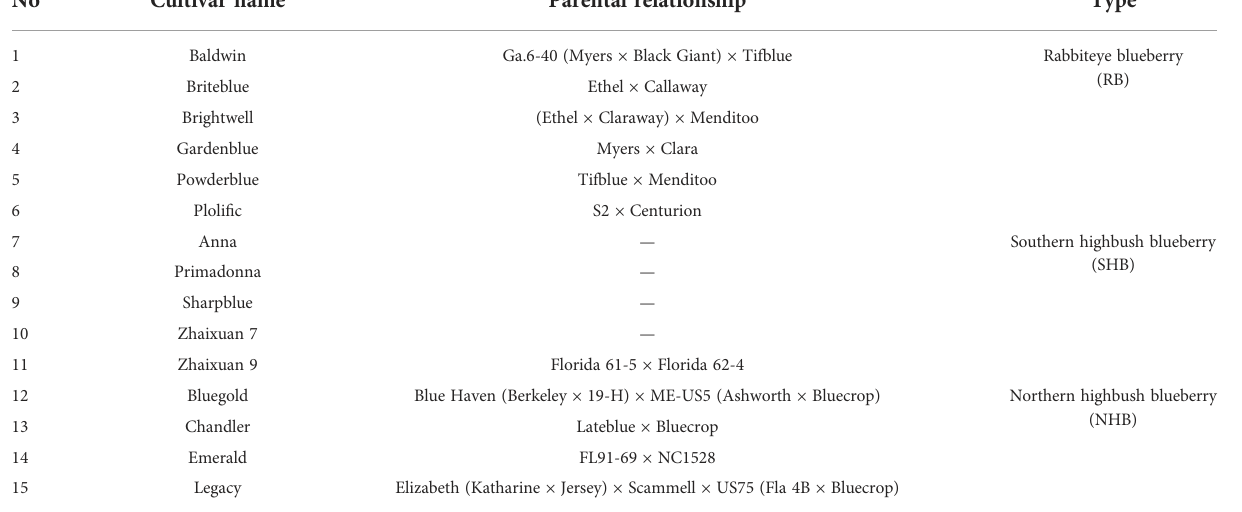
TABLE 1 List of the 15 blueberry cultivars